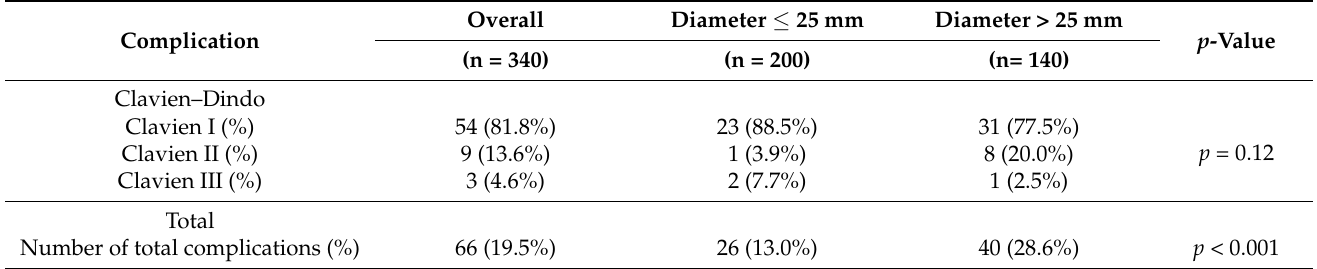
Table 2. Complications occurred in the two groups and the overall population.